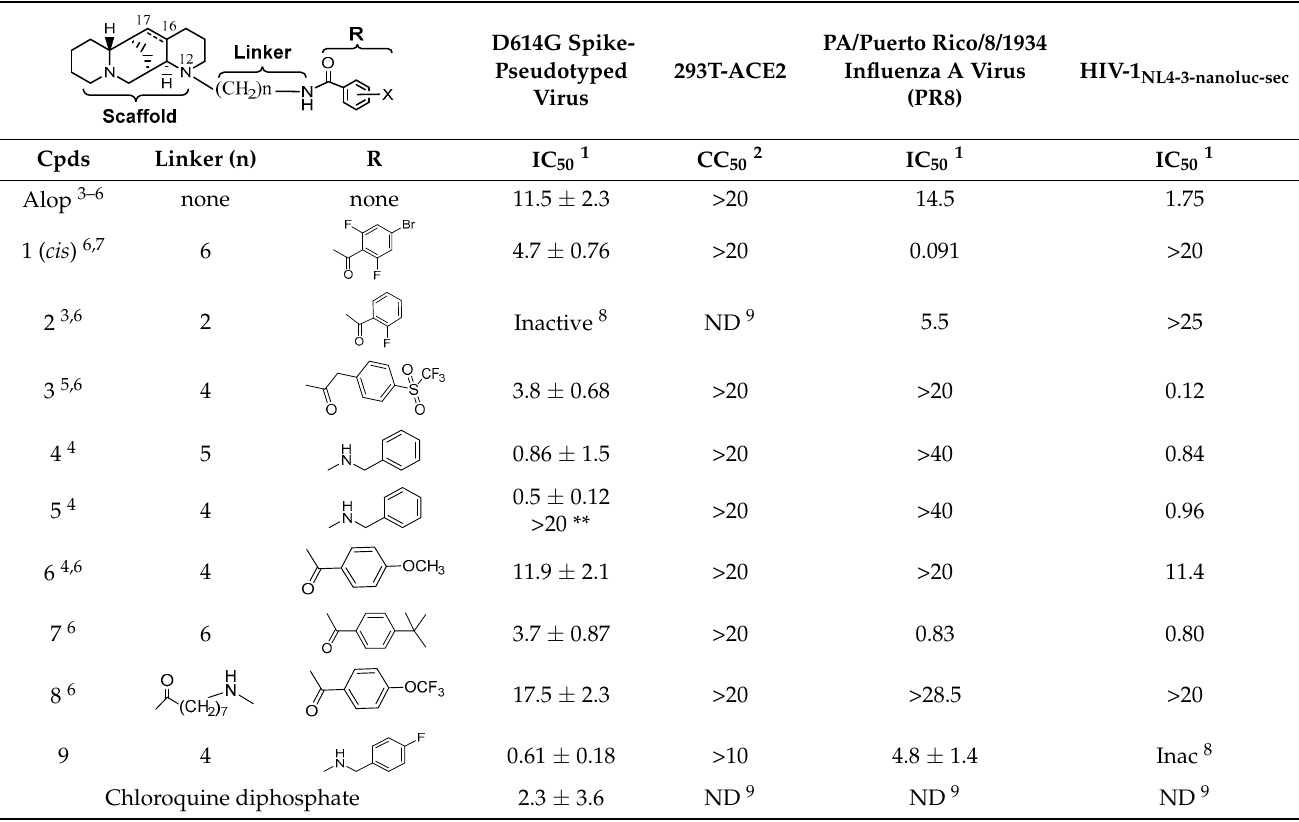
Table 1. Inhibition of D614G spike-pseudotyped virus entry by aloperine derivatives.